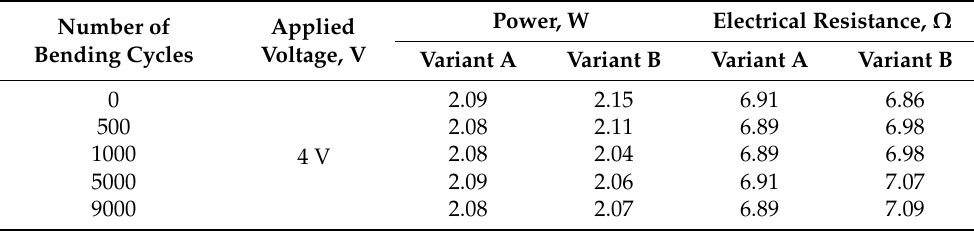
Table 6. Electrical properties of heating inserts (variant A and B) after multiple bending cycles. Number of Bending Cycles